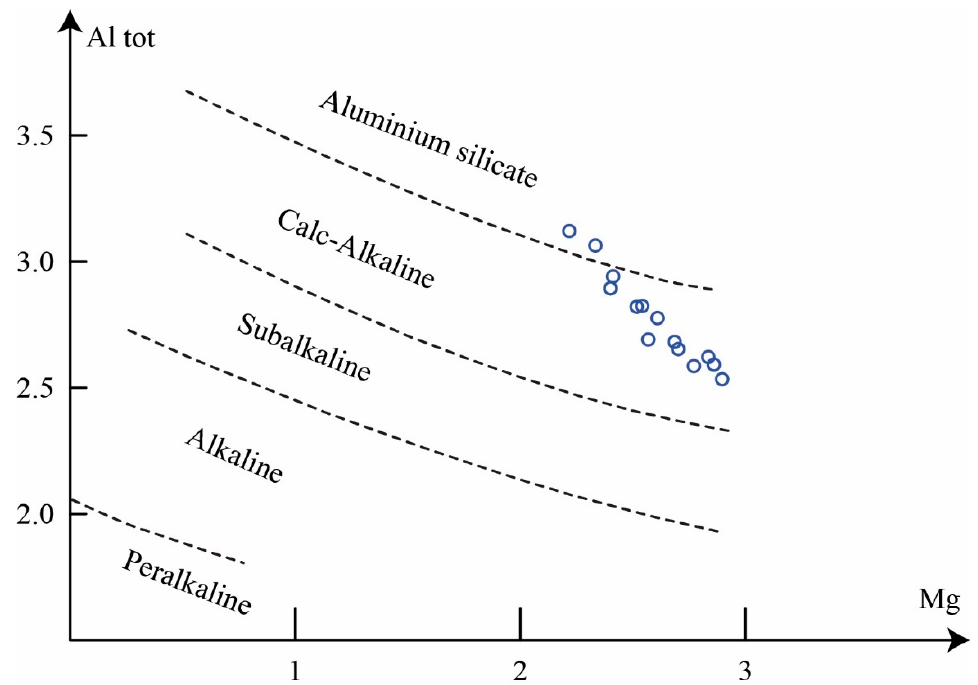
Figure 17. Position of the analyzed biotites in the Altot–Mg diagram of [46]. Blue circles indicate the analyzed Biotites.